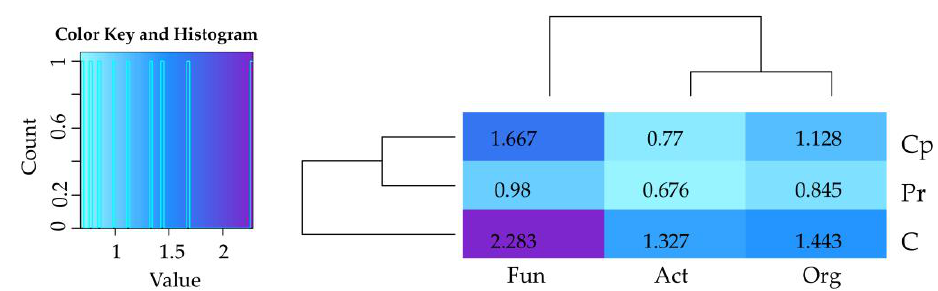
Figure 4. Index of the influence of Zea mays (IF Zm ) on the number of microorganisms. Org—organotrophic bacteria; Act—actinomycetes; Fun—fungi; C—soil uncontaminated; Pr—soil contaminated with permethrin; Cp—soil contaminated with cypermethrin.